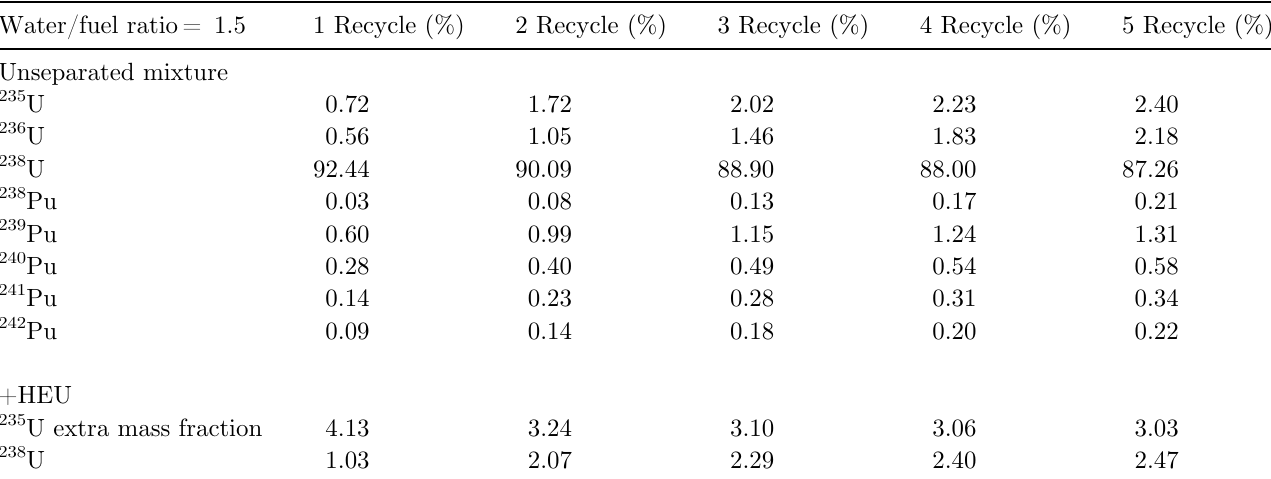
Table 1. REMIX fuel composition for FA with water/fuel ratio = 1.5. Water/fuel ratio = 1.5